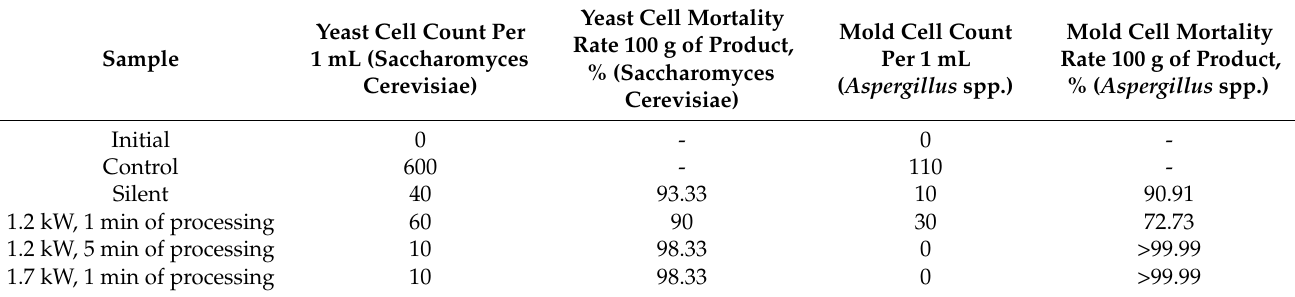
Table 2. Yeast and mold mortality rate according to processing